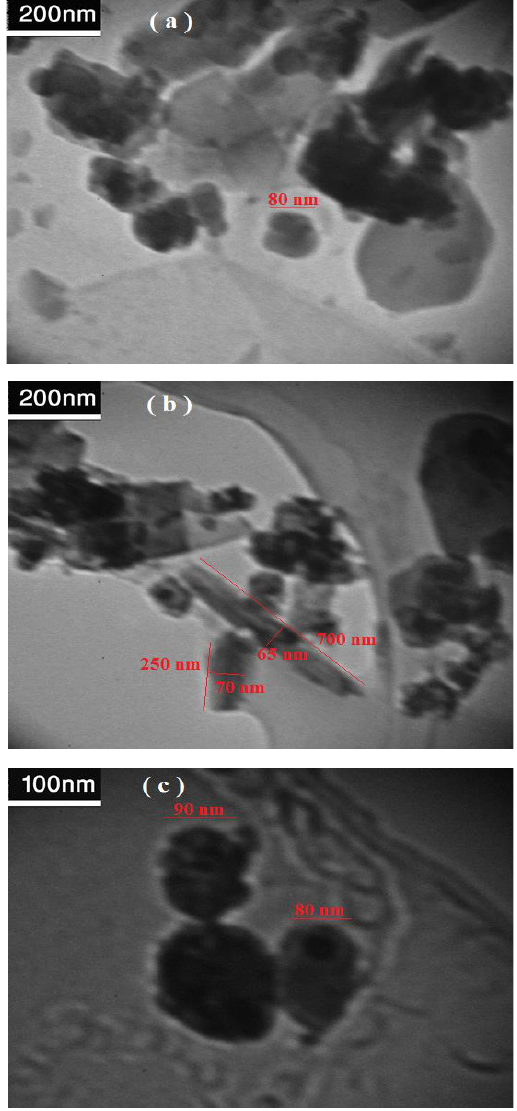
Fig. 6. Pseudo first-order kinetic model fit for Cd2+ sorption onton natural